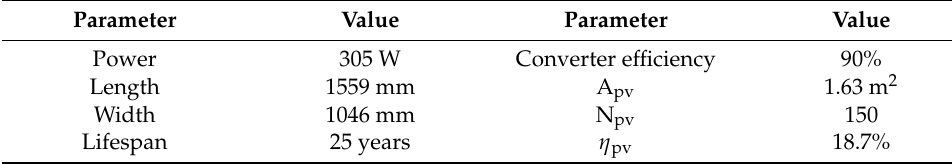
Table 4. Parameters of solar PV module.